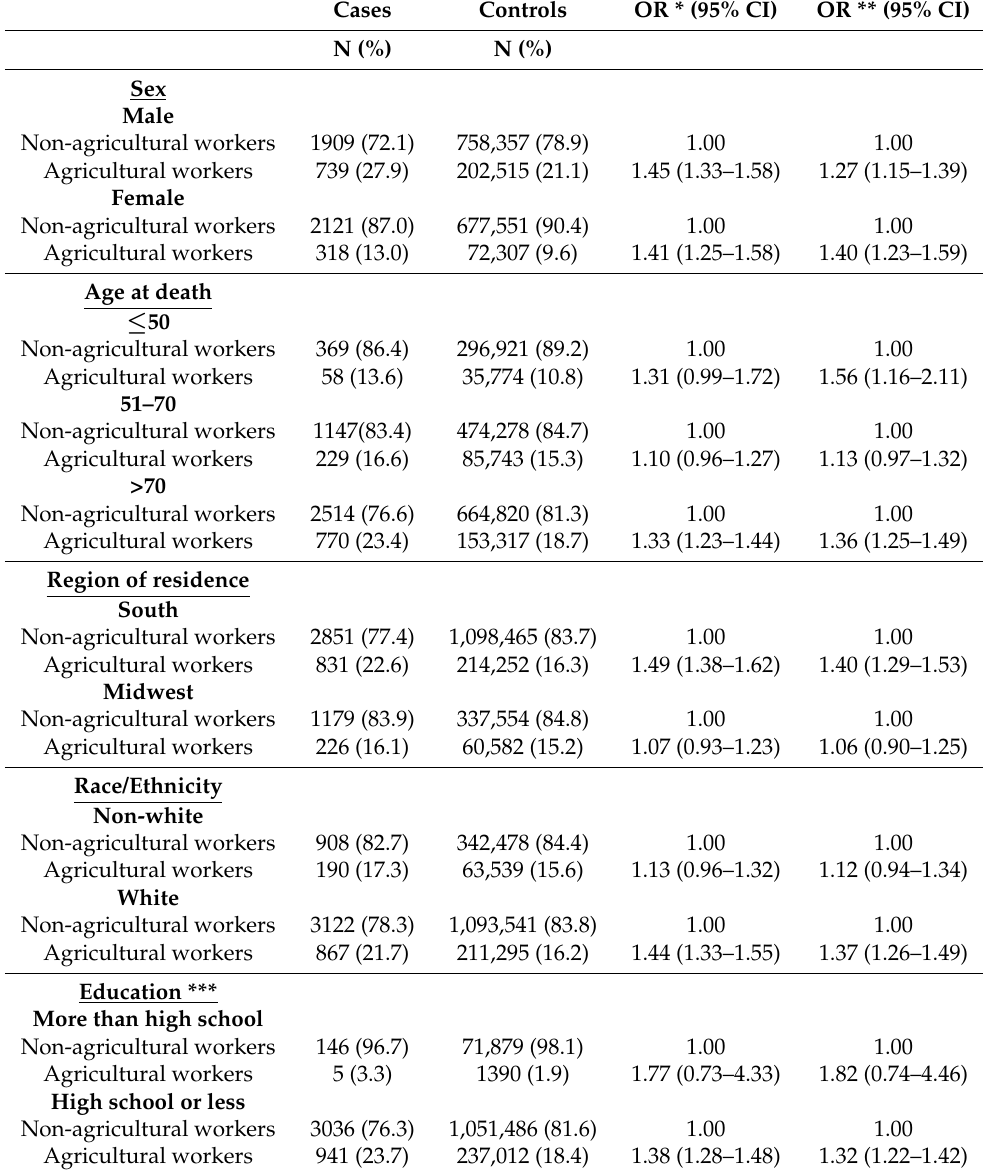
Table 2. Overall, adjusted, and stratified AKF mortality among Brazilian southern and midwestern agricultural workers, 2006–2014.